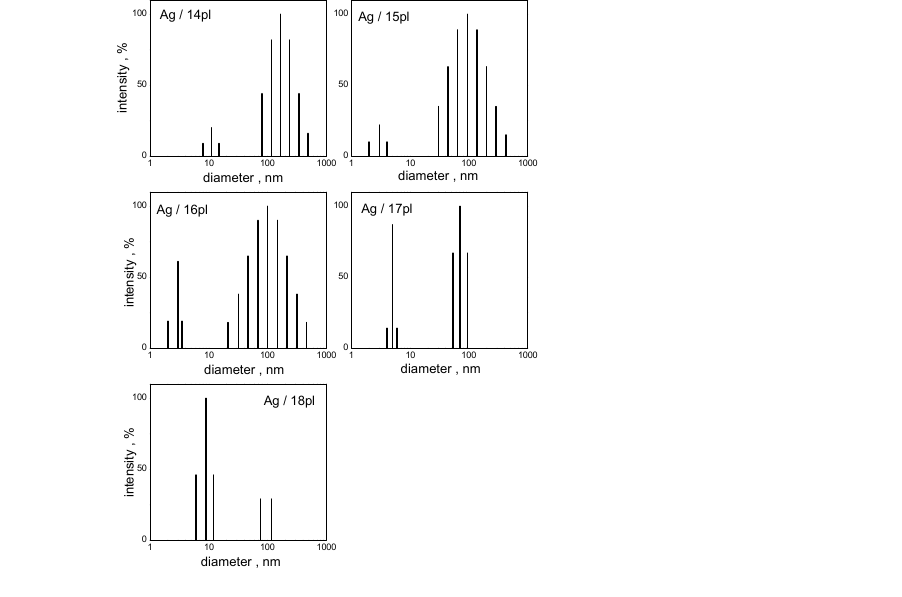
Figure 4. Particle size spectra of AgNPs stabilized with phospholium surfactants at n Ag /n surf = 4. The bimodal particle size distribution shows the population of small nanoparticles of the diameter 5–10 nm (Figure 4). This population of small nanoparticles seems to be in- creasing in terms of intensity with the increasing alkyl chain length. The peak in the par- ticle size spectra related to the particles approx. 100 nm large in size may be related to the population of individual large nanoparticles or clusters of smaller nanoparticles. Accord- ing to the published studies, chemical method of AgNPs preparation utilizing reducing agents such as sodium borohydride, hydrazine, sodium citrate, and others, results in the formation of mostly spherical silver nanoparticles that are larger in size, typically in the size range 40–60 nm [59]. This size polydispersity of AgNPs corresponds with the broad peaks in particle size spectra (Figure 4), especially for AgNPs stabilized with short-chain surfactants 14pl – 16pl . On the other hand, worse stabilizing effect of short-chain surfac- tants may result in the formation of AgNPs prone to agglomerate into larger clusters, which would explain the presence of the peaks around the size of 100 nm in the particles size spectra. The SEM images of AgNPs (Figure 5) indicate the coexistence of small AgNPs with large aggregates. High resolutions SEM images are shown in the Supplementary material. The trend of increasing population of small AgNPs with the increasing alkyl chain length of stabilizing surfactant (Figure 5) corresponds with that shown in particle size distribu- tions in Figure 4.